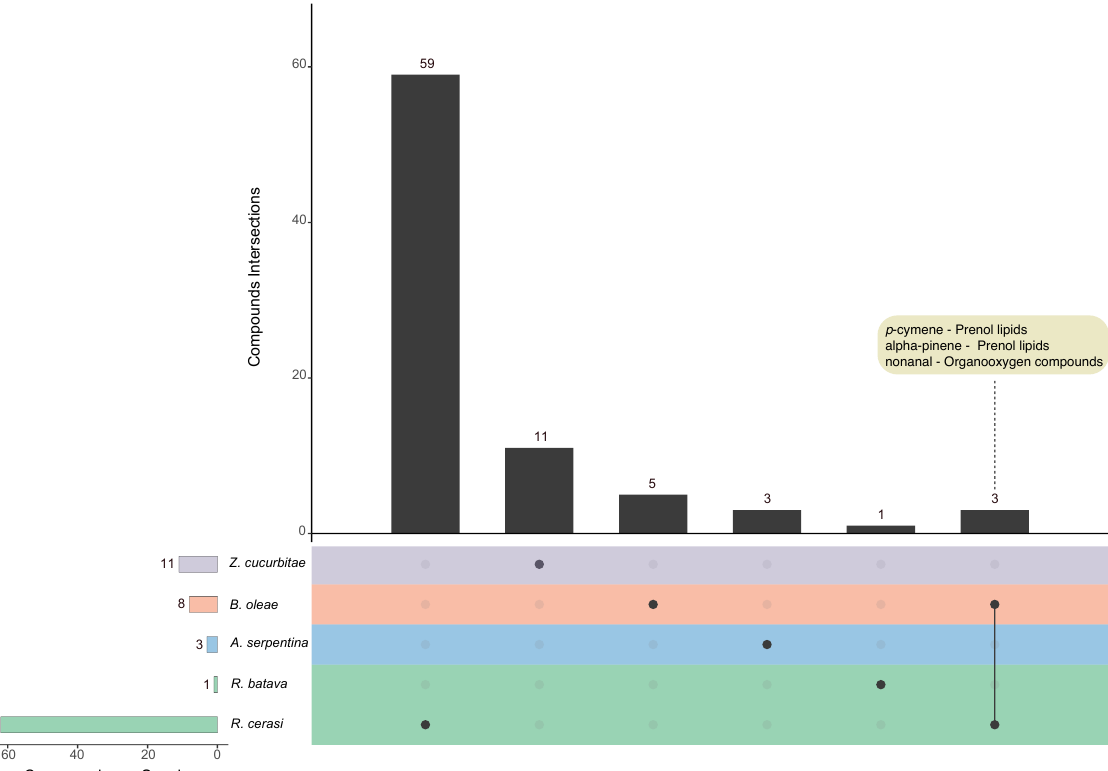
Figure 5. Comparison among the chemicals identified in the headspace emissions of monophagous and oligophagous tephritid species. UpSet plot showing unique and overlapping chemicals across five species belonging to the Zeugodacus , Bactrocera , Anastrepha and Rhagoletis genera. The intersection matrix is sorted in descending order. Connected dots represent intersections of overlapping chemicals and horizontal bars show the total number of compounds identified in each species headspace. The plot was generated using the UpSetR package in R